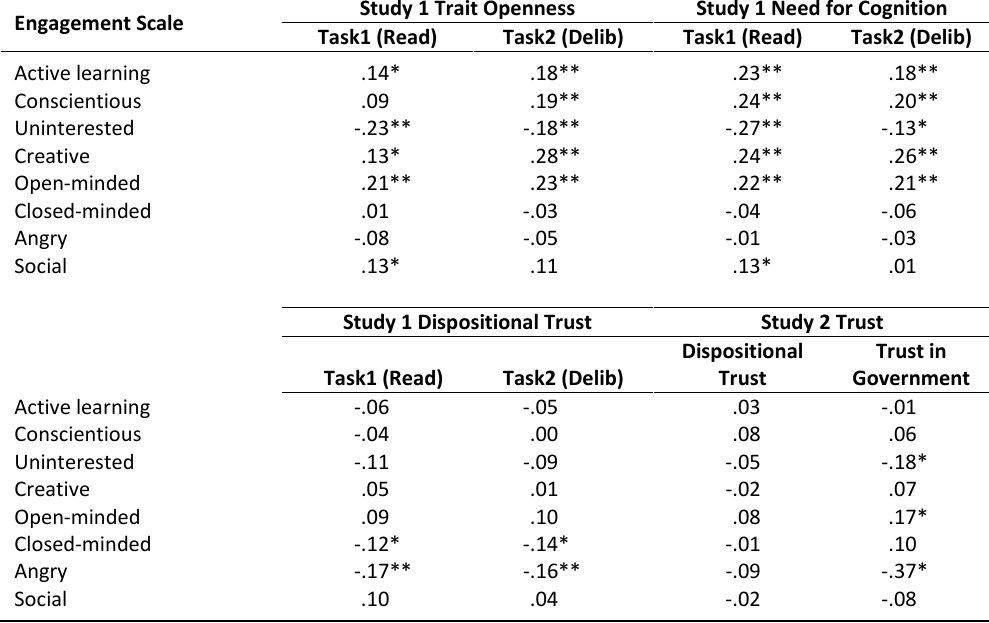
Table 6. Correlations between Engagement Scales and Personality Variables Study 1 Trait Openness Study 1 Need for Cognition Engagement Scale Task1 (Read) Task2 (Delib) Task1 (Read) Task2 (Delib) Active learning .14* .18** .23** .18** Conscientious .09 .19** .24** .20** Uninterested -.23** -.18** -.27** -.13* Creative .13* .28** .24** .26** Open-minded .21** .23** .22** .21** Closed-minded .01 -.03 -.04 -.06 Angry -.08 -.05 -.01 -.03 Social .13* .11 .13* .01 Study 1 Dispositional Trust Study 2 Trust Dispositional Trust in Trust Government Task1 (Read) Task2 (Delib) Active learning -.06 -.05 .03 -.01 Conscientious -.04 .00 .08 .06 Uninterested -.11 -.09 -.05 -.18* Creative .05 .01 -.02 .07 Open-minded .09 .10 .08 .17* Closed-minded -.12* -.14* -.01 .10 Angry -.17** -.16** -.09 -.37* Social .10 .04 -.02